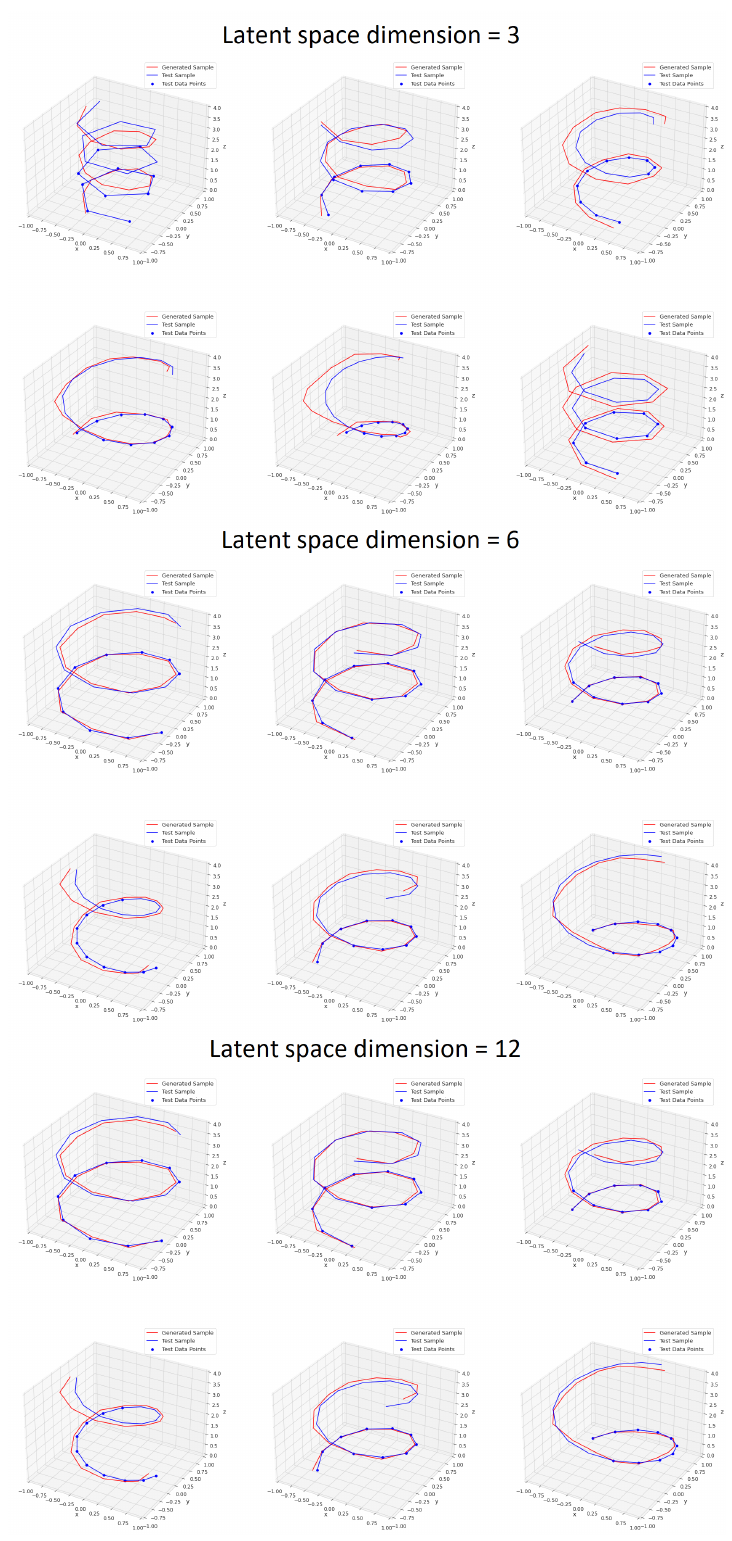
Figure 20. The figures above show the generated data using the prediction function on real samples (rows 1, 3, 5) and test samples (rows 2, 4, 6) when the size of the latent space is 3,6 and 12 respec- tively. The blue lines indicate the real spiral, the solid blue dots show the 10 data points that are constrained using Algorithm 1 and the red lines show the spiral produced by the generator for these 10 constrained